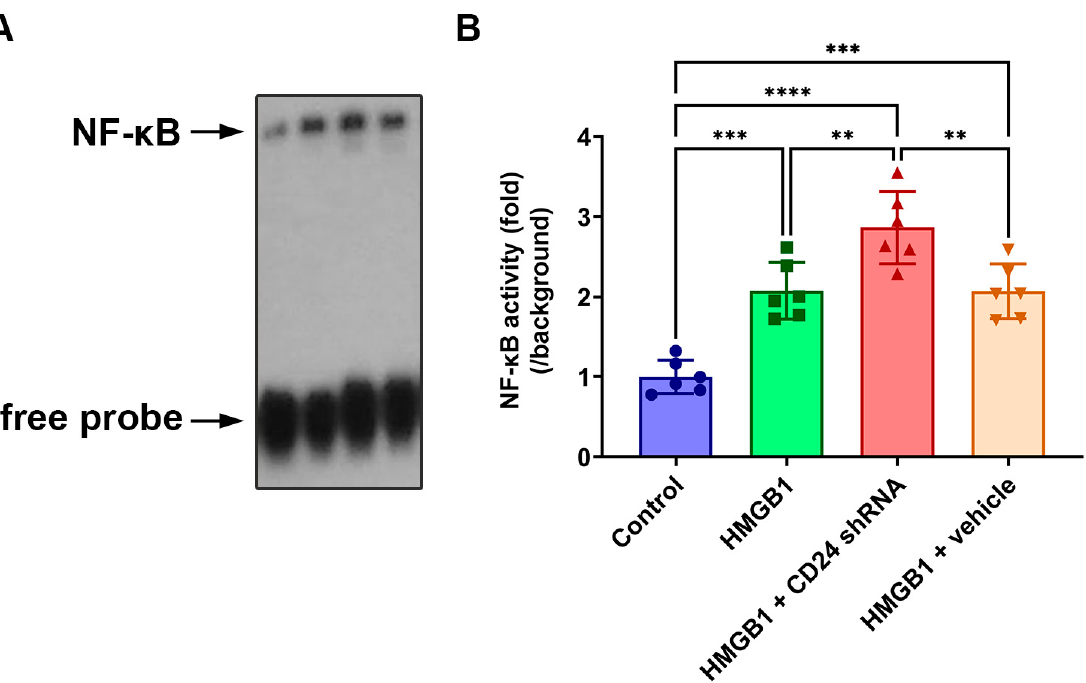
Figure 3. EMSA was used to explore the NF- κ B DNA-binding activity in cultured astrocytes in all groups. ( A ) Measurement of NF- κ B DNA-binding activity in cultured astrocytes in all groups. Lanes 1, 2, 3, and 4 represent the control group, HMGB1 group, HMGB1 + shRNA group, and HMGB1 + NC group, respectively; ( B ) Quantitative analysis showed that NF- κ B DNA-binding activity in HMGB1 + shRNA group was markedly higher than any other. Bars represent the mean ± SD ( n = 6, each group). ** p < 0.01, *** p < 0.001, **** p < 0.0001 vs. control or indicated groups. Statistical comparison was conducted using one-way ANOVA; p < 0.05 was considered statistically